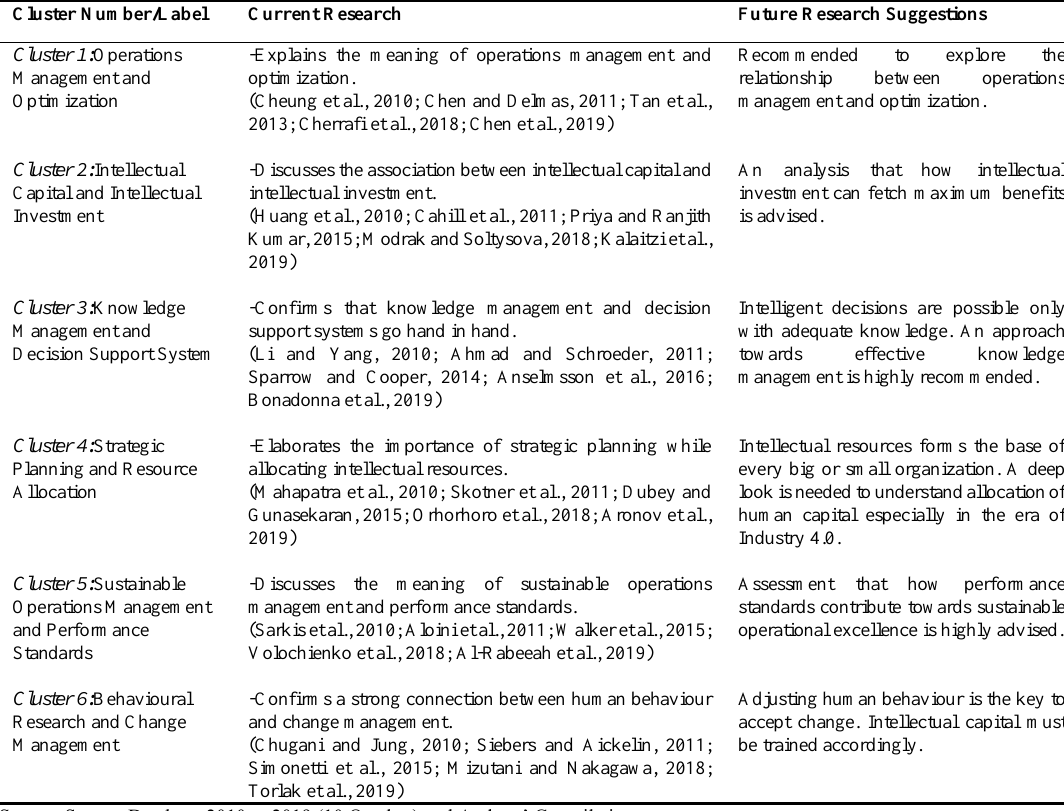
Table 12. Identified clusters: intellectual capital and operational excellence Cluster Number/Label Current Research Future Research